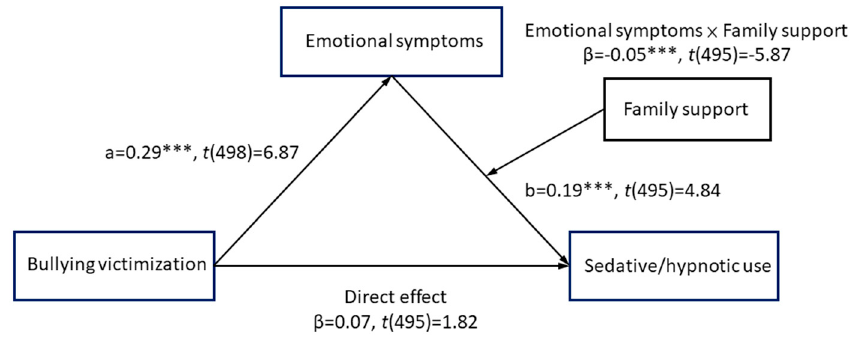
Figure 2. Final model indicating the co-efficient estimates and statistical significance.